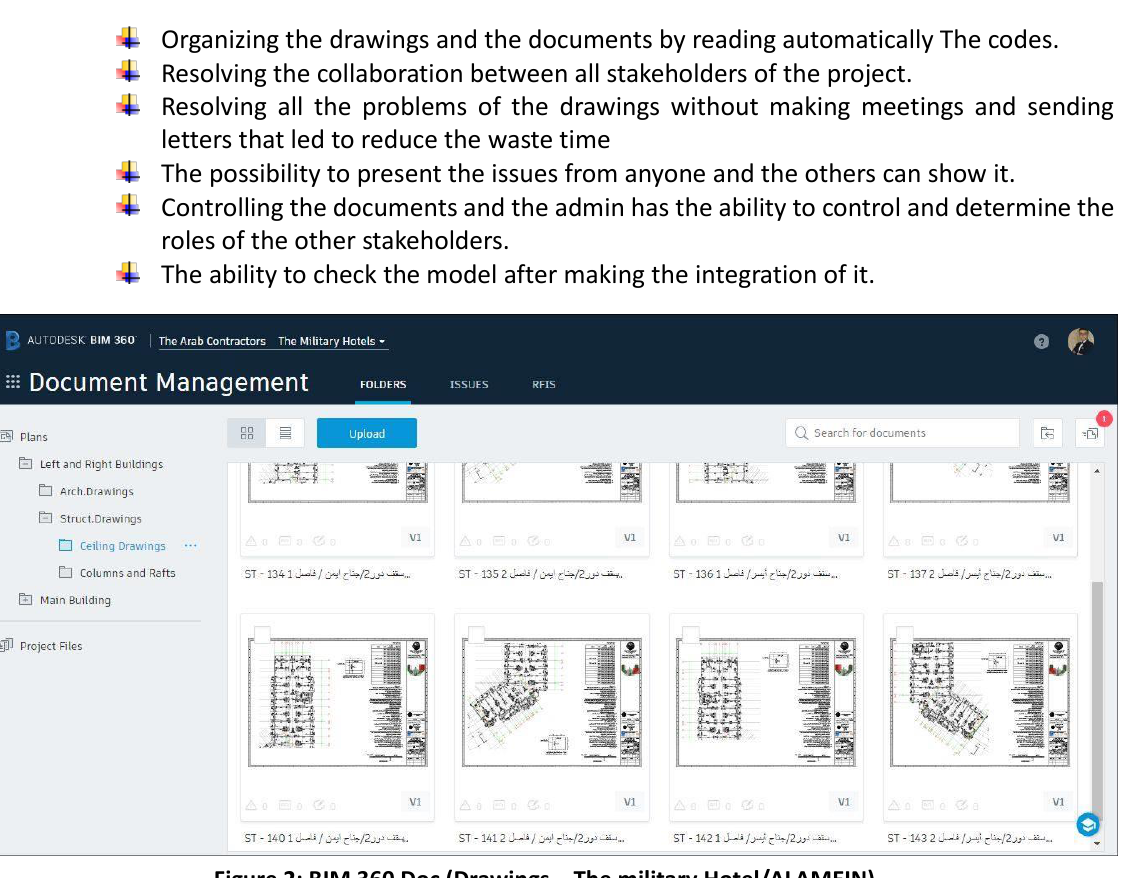
Figure 2: BIM 360 Doc (Drawings – The military